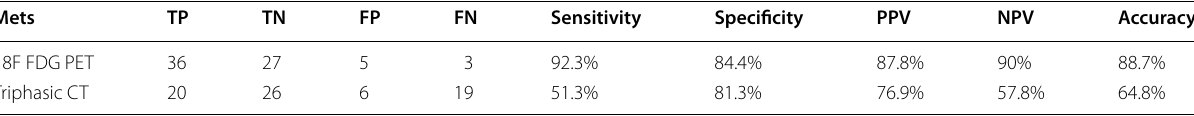
Table 3 Diagnostic performance of CT and 18F FDG PET/CT (according to number of metastases) Mets